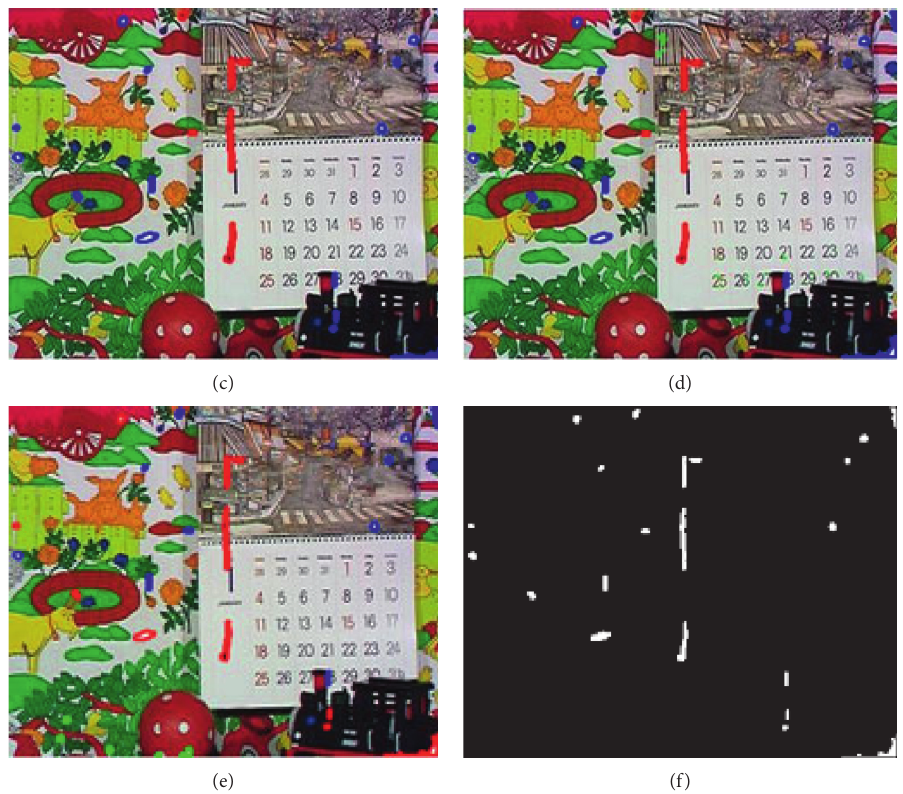
Figure 14: Results of different coloured artificial blotch detection studies for “calendar” dataset: (a) the HOG feature, (b) the LBP feature, (c) the region matching, (d) the SDI, (e) the proposed method, and (f) the mask demonstrating blotch regions.